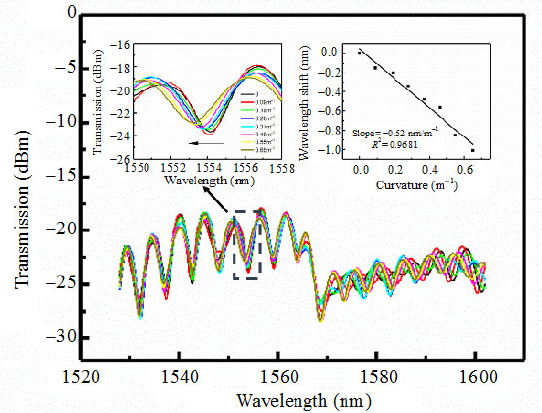
Fig. 6 Transmission spectrum change of the SMF-DCF-SMF